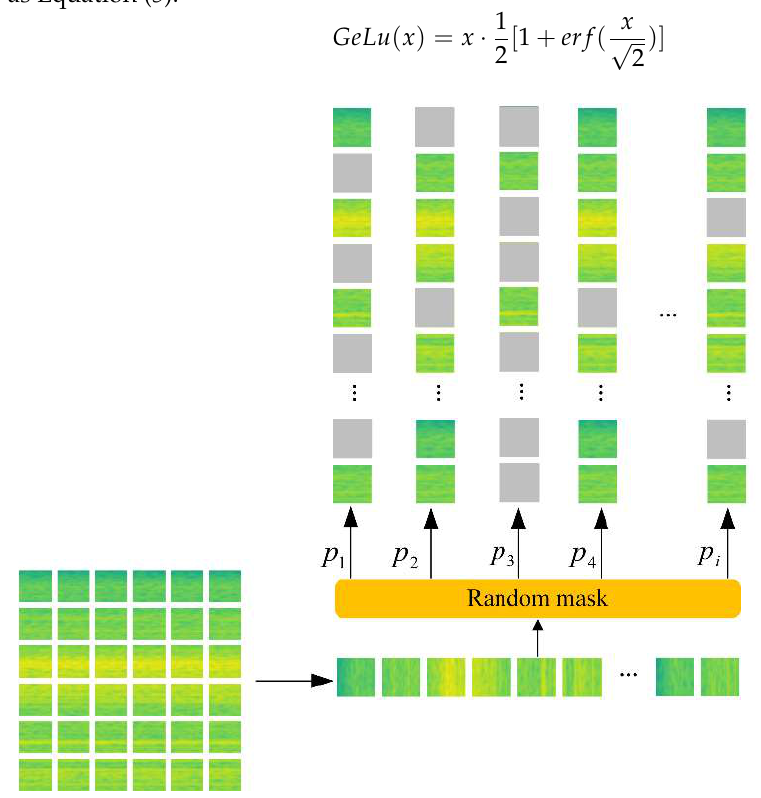
Figure 4. The Random mask training strategy.